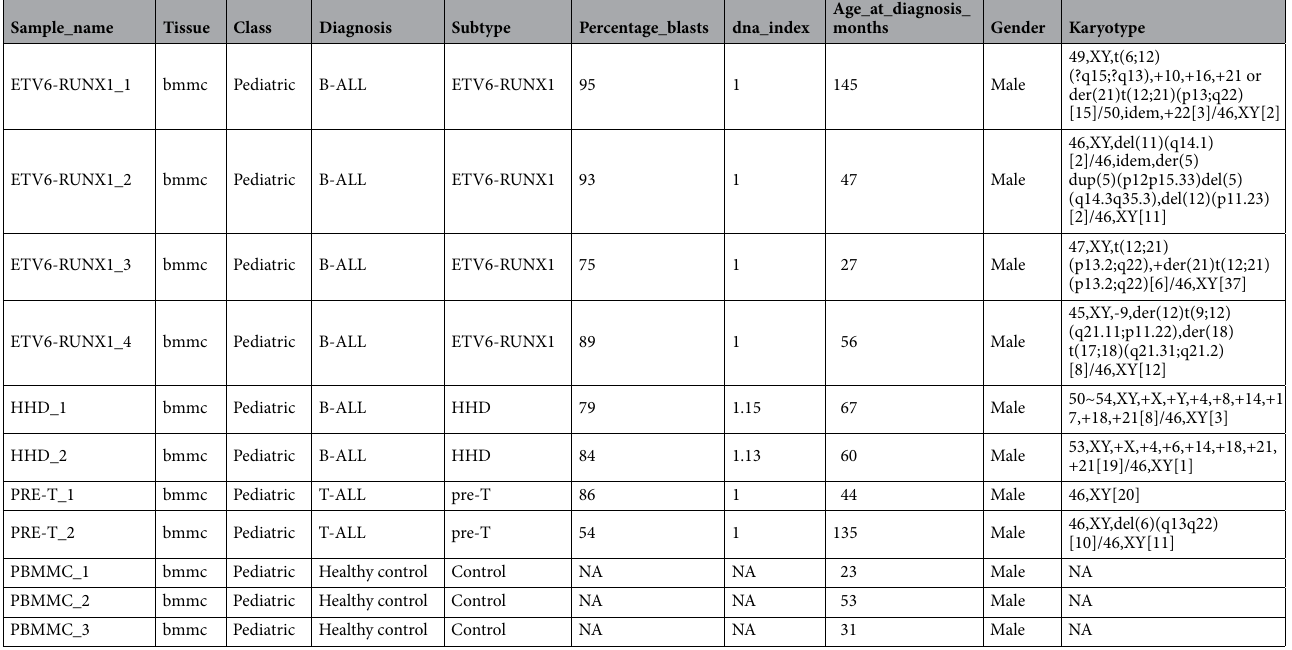
Table 1. A correct version of the original Table 1.